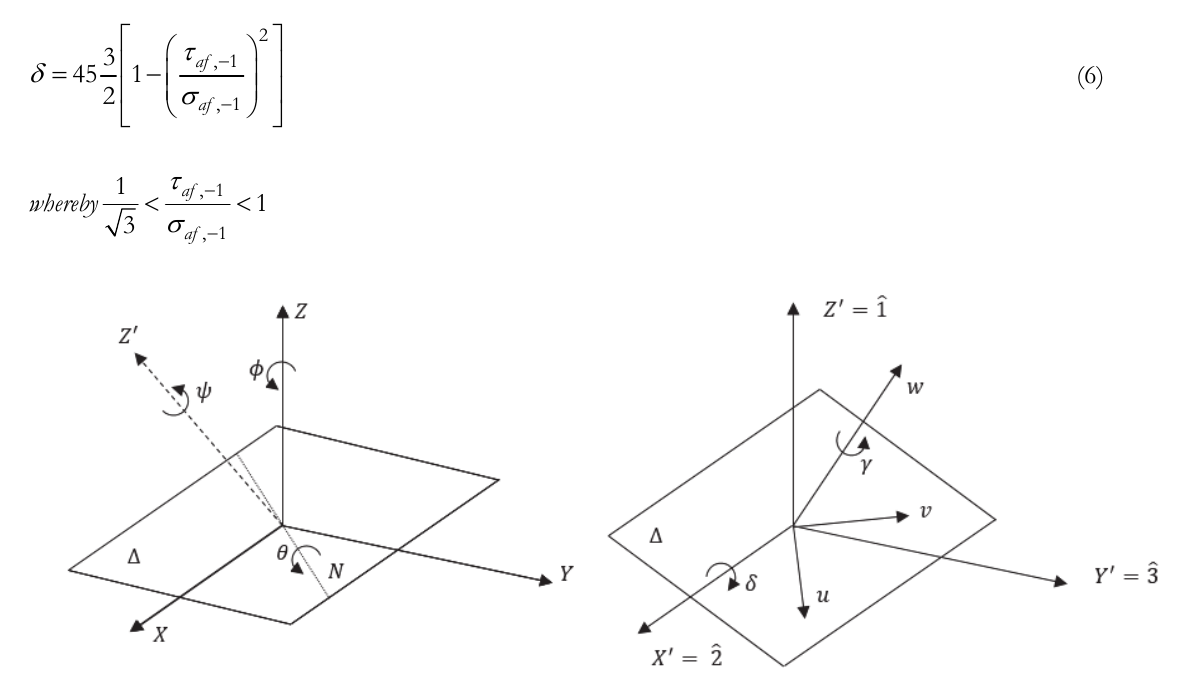
Figure 3: Representation of the counter clockwise rotations about the , Z N and ' Z axis, defined through three Euler angles , ,  (a) Relationship between the two spherical angles  and  with respect to the local coordinate system with axes uvw (b); Reproduced from